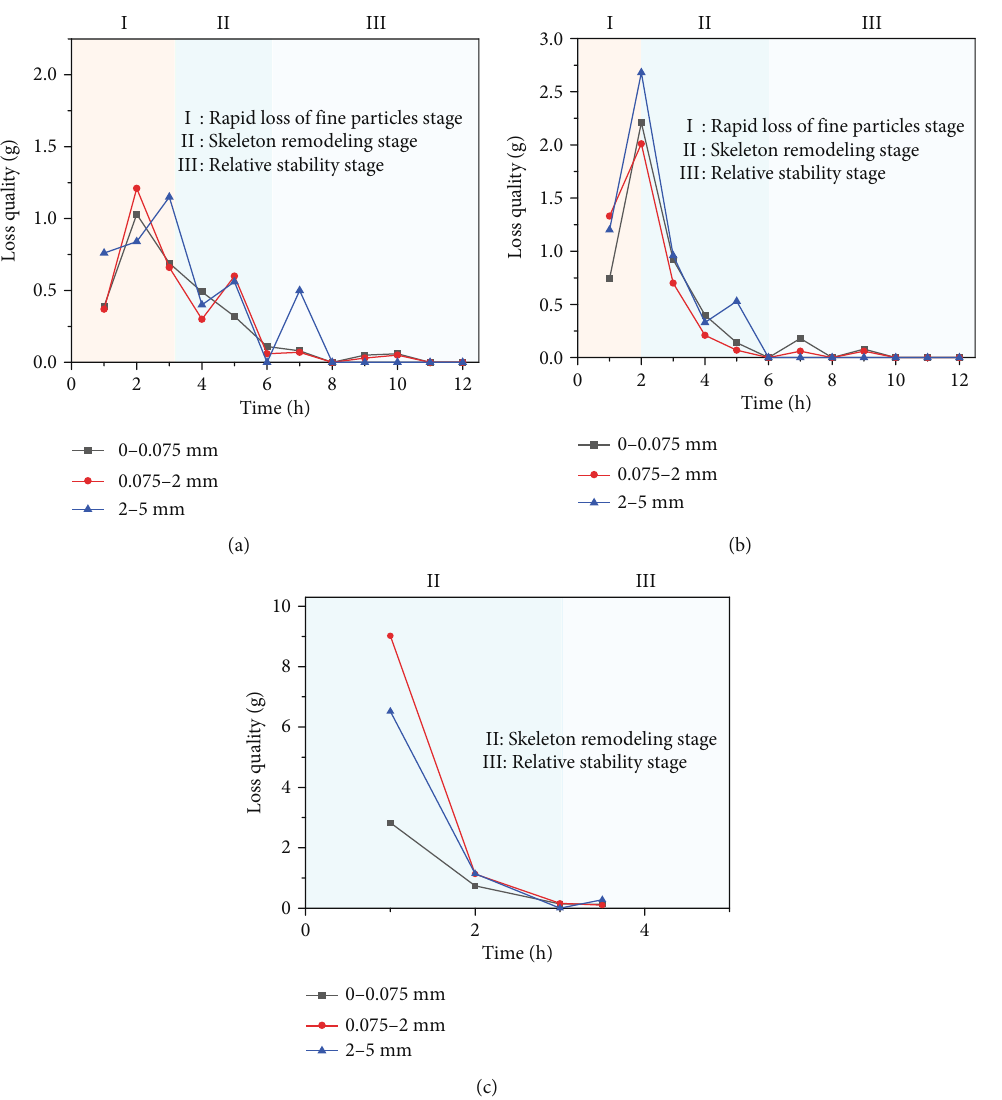
Figure 6: Time-varying curve of particle loss from SRM fi ller under di ff erent rainfall conditions: (a) moderate rain condition; (b) rainstorm condition; (c) short-term heavy rainfall condition.